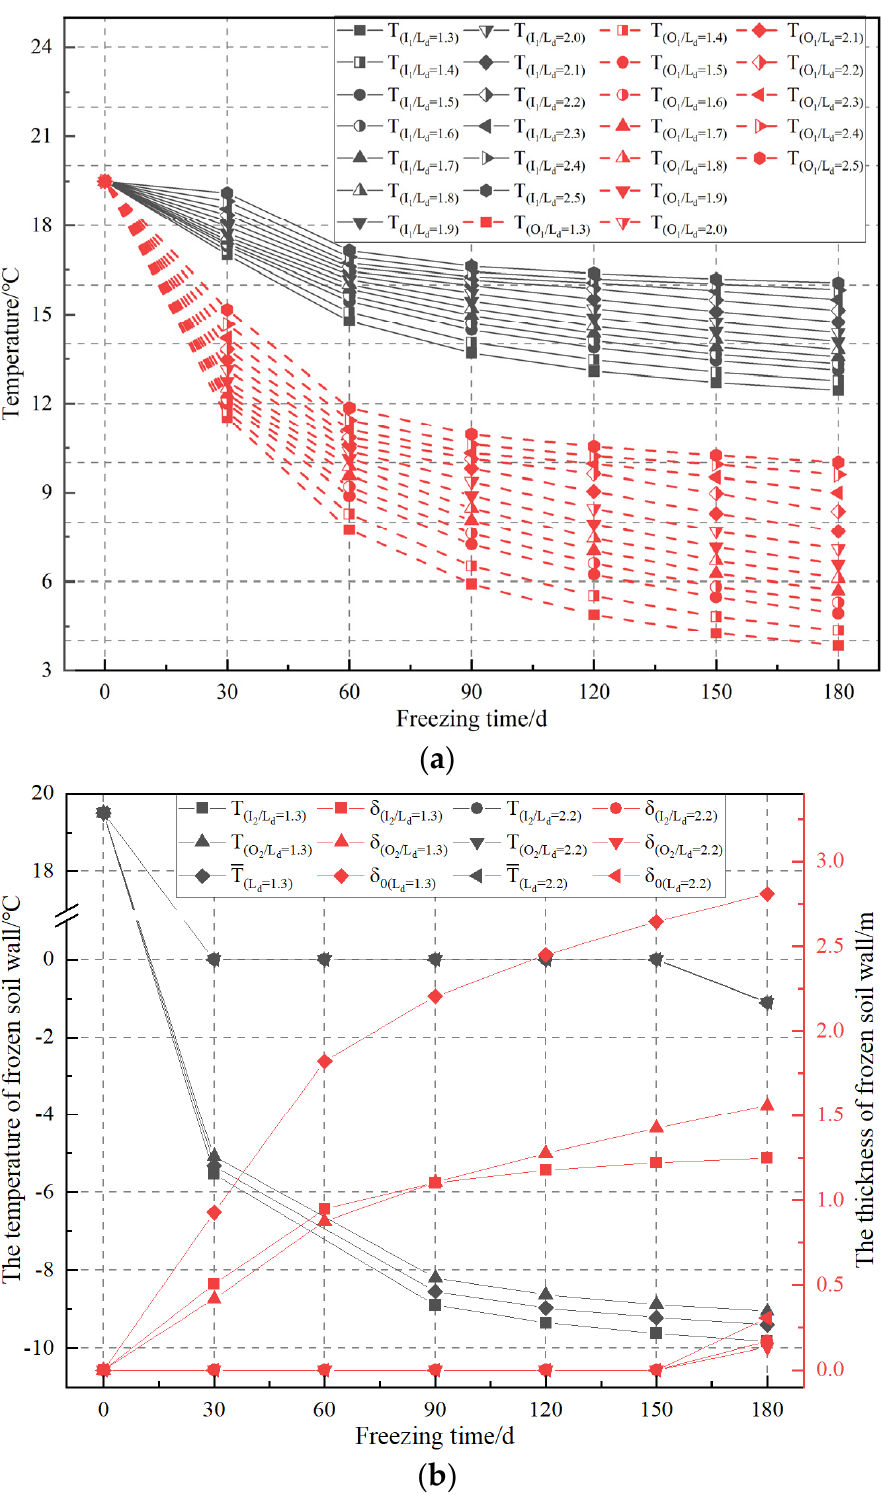
Figure 12. Variance in temperature and thickness under different freezing tube pitches and freezing time: ( a ) temperature in interlayer and outside wall of shaft, ( b ) temperature and thickness in the inside and outside of frozen soil wall and its average or sum value with freezing tube pitches of 1.3 m and 2.5 m.